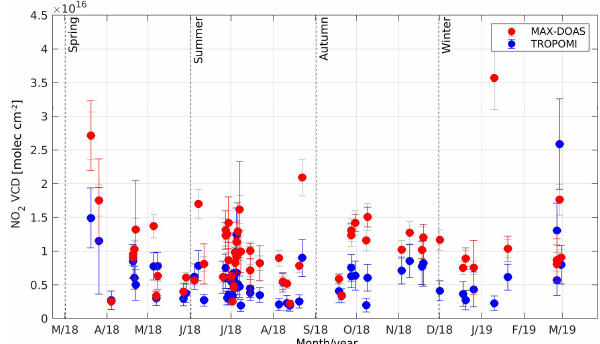
Figure 12. Time series of the tropospheric NO 2 columns derived from the main azimuthal MAX-DOAS direction observations in the visible range and the closest TROPOMI pixel located along the MAX-DOAS azimuthal direction. The MAX-DOAS error bars (red lines) represent the standard deviation of the averaged values within 1h before and after TROPOMI’s overpass time, and the grey error bars correspond to typical MAX-DOAS inversion uncertainty. The TROPOMI error bars are equal to the TROPOMI VCD error as pro- vided in the data